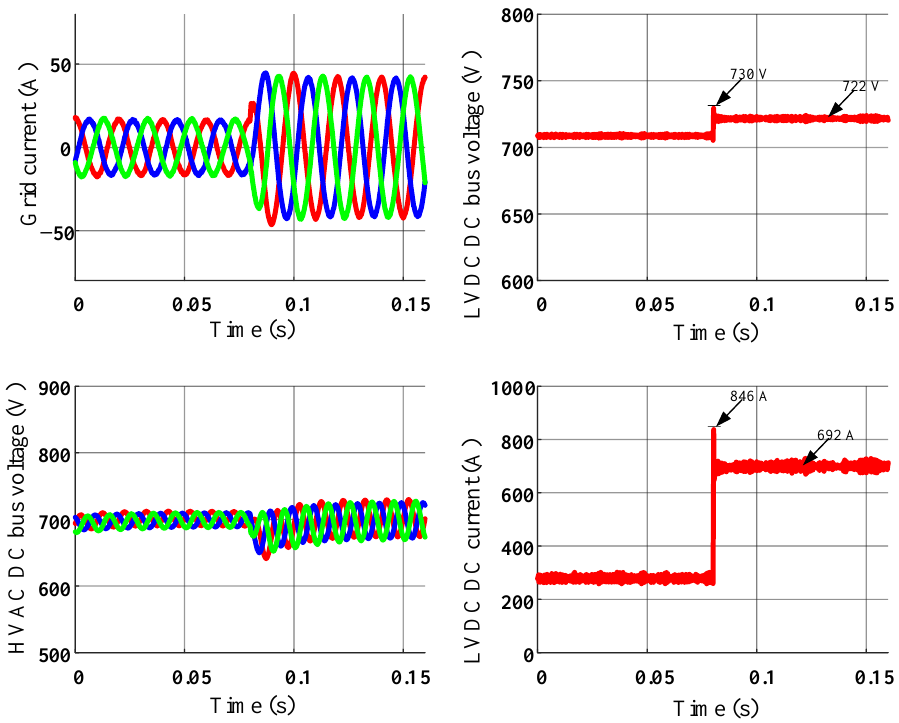
Figure 9. Simulation waveform (power from 20% step to 50% rated power).